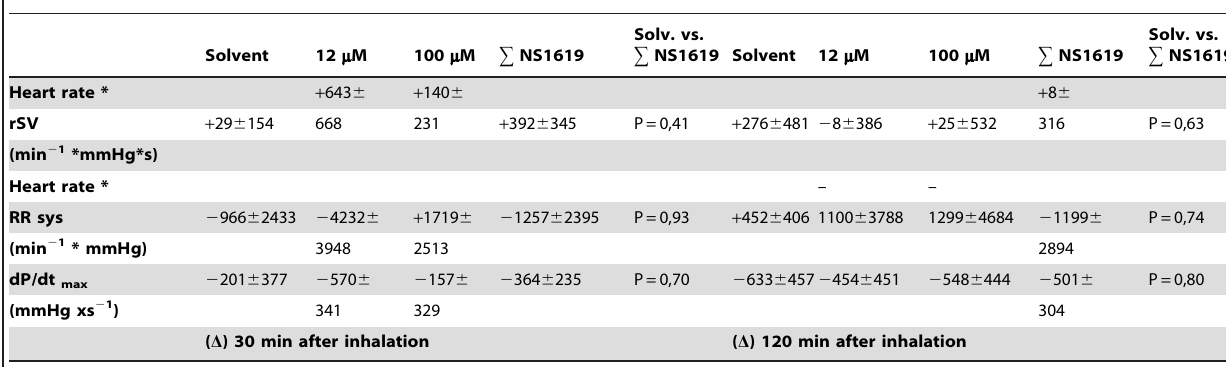
Table 4. Left ventricular